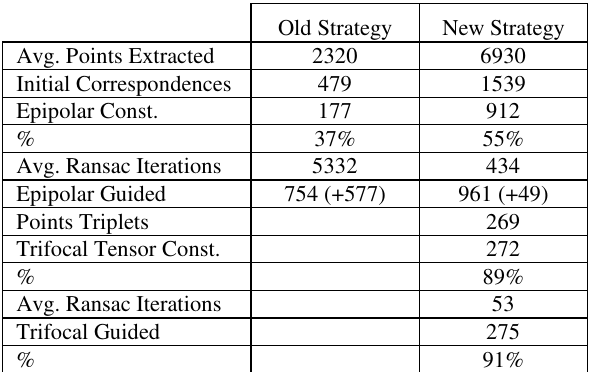
Table 9. Comparison summary of the Castle sequence.